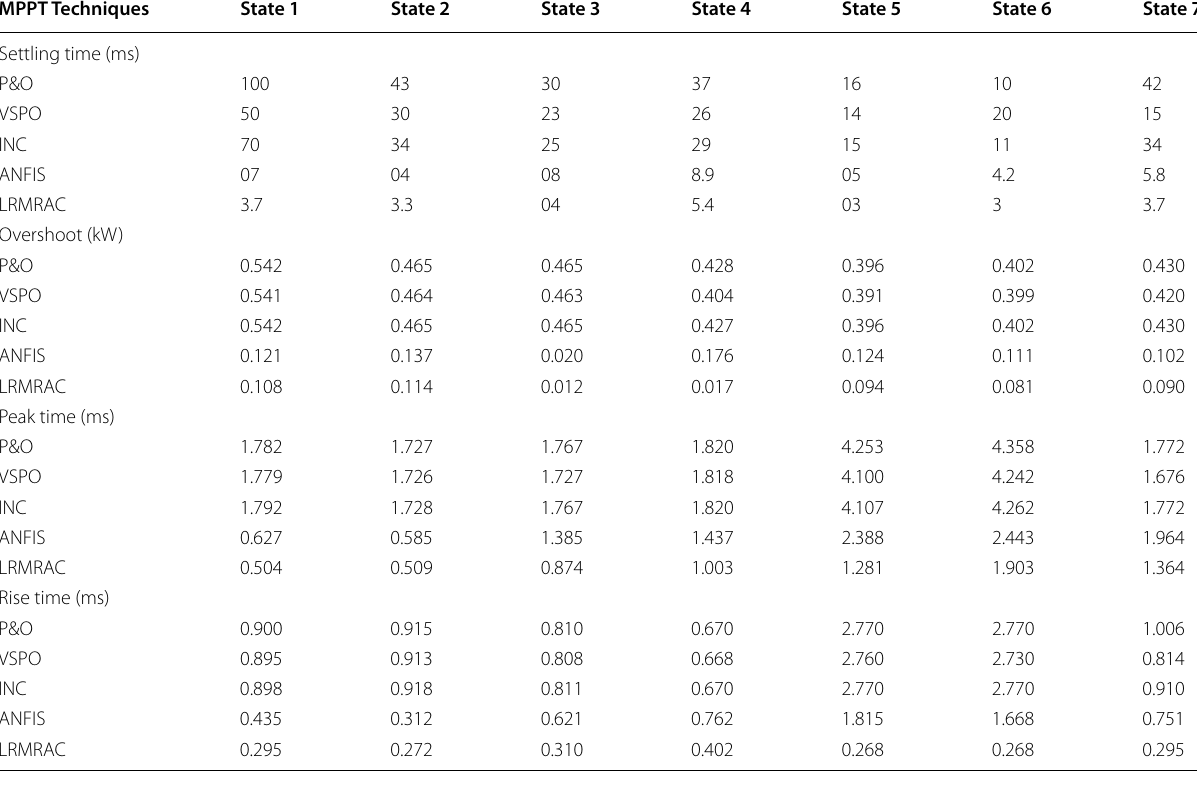
Table 3 Time domain analysis of the five approaches in seven states using various parameters MPPT Techniques